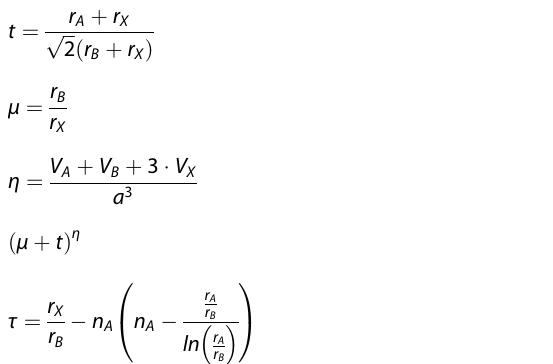
of simple perovskite and double perovskite, de fi ning when τ of the compounds less than 4.18 represents perovskite with 91% accuracy.